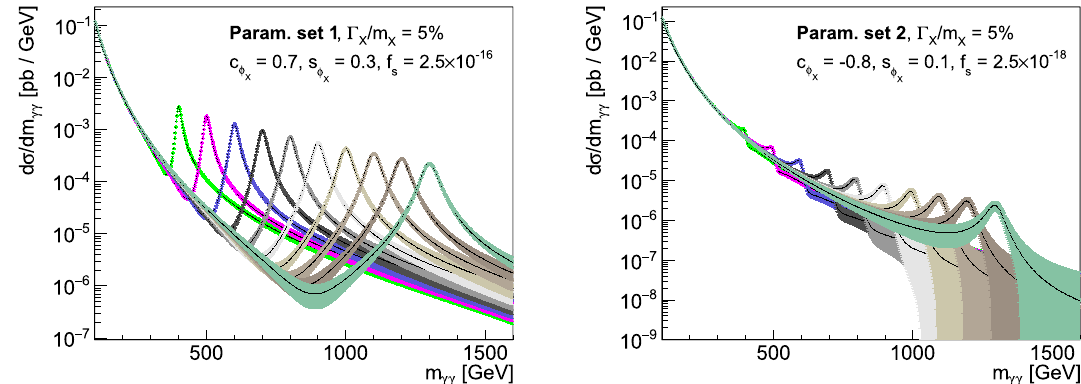
Fig. 5 Visualisation of Asimov datasets, generated using the PM functional form at various mass points with (cid:3) X / m X = 5%, for the two different sets of input c φ , s φ , and f s X X